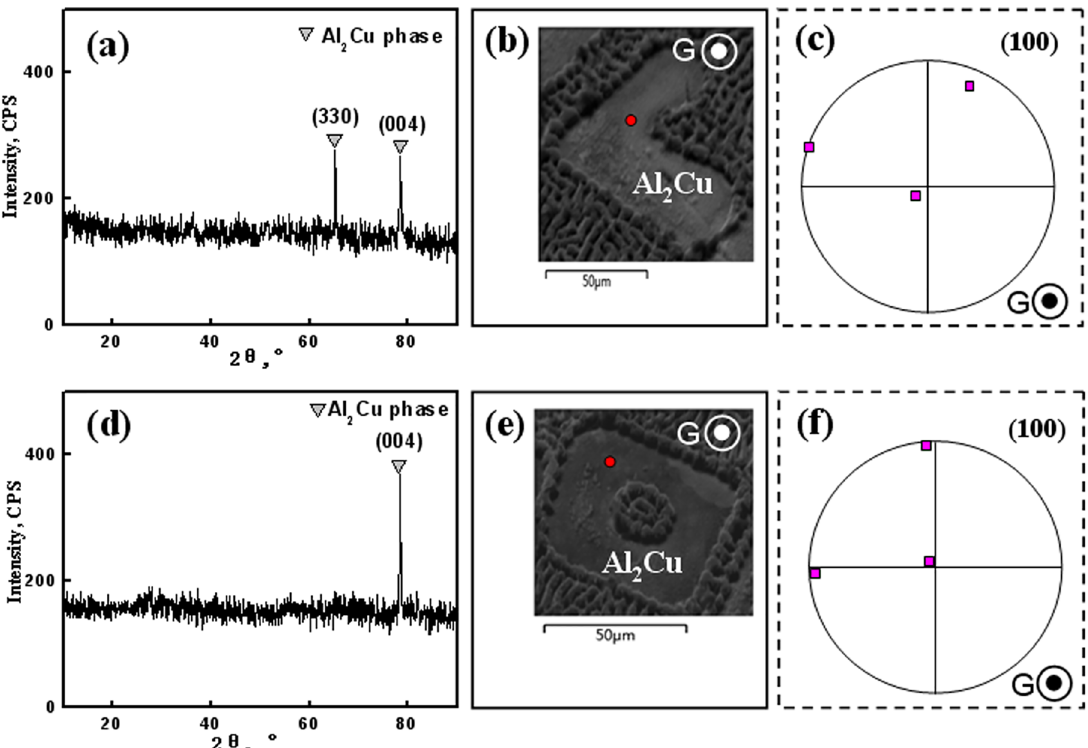
Figure 6. The 4 mm sample under directionally solidified in transverse section: (a) XRD patterns, (b) the position of EBSD testing, and (c) (100)-pole figure of Al